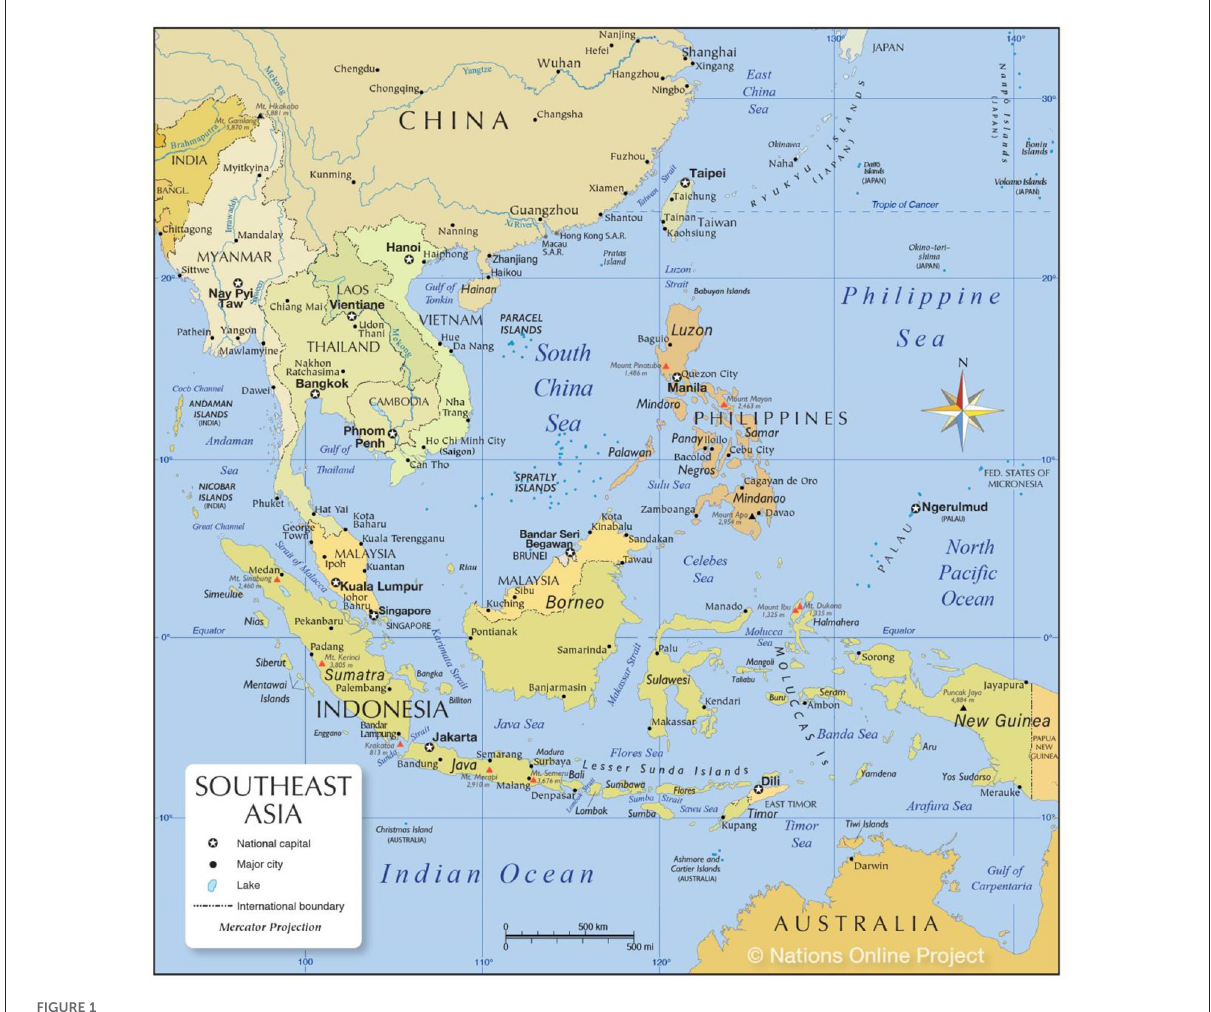
FIGURE1 A map of Southeast Asia